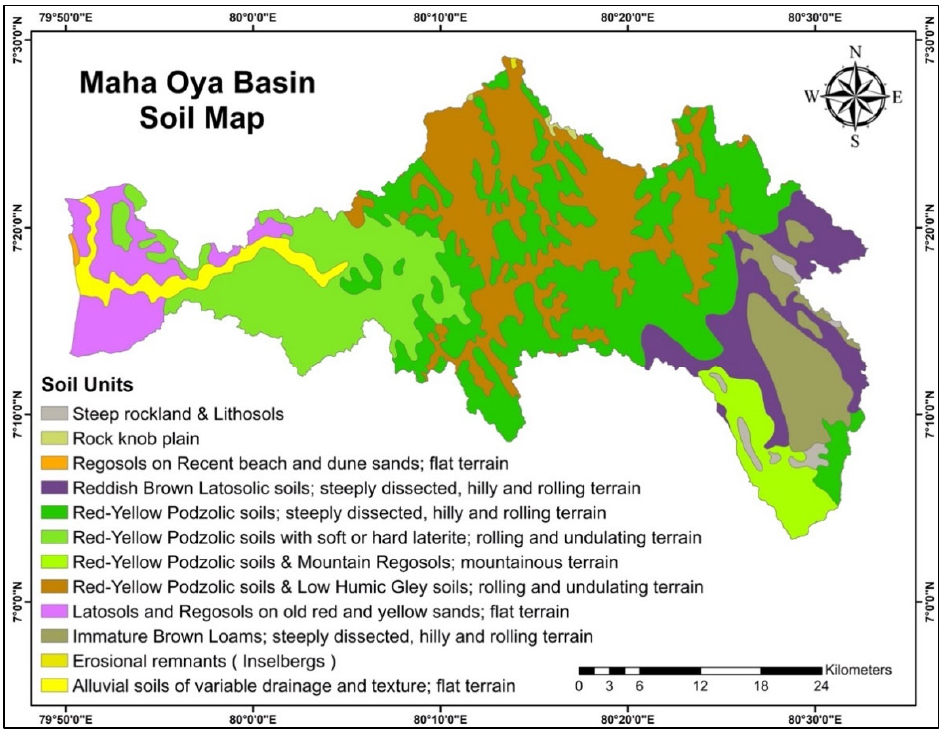
Figure 3. Map of soil types in Maha Oya River Basin.